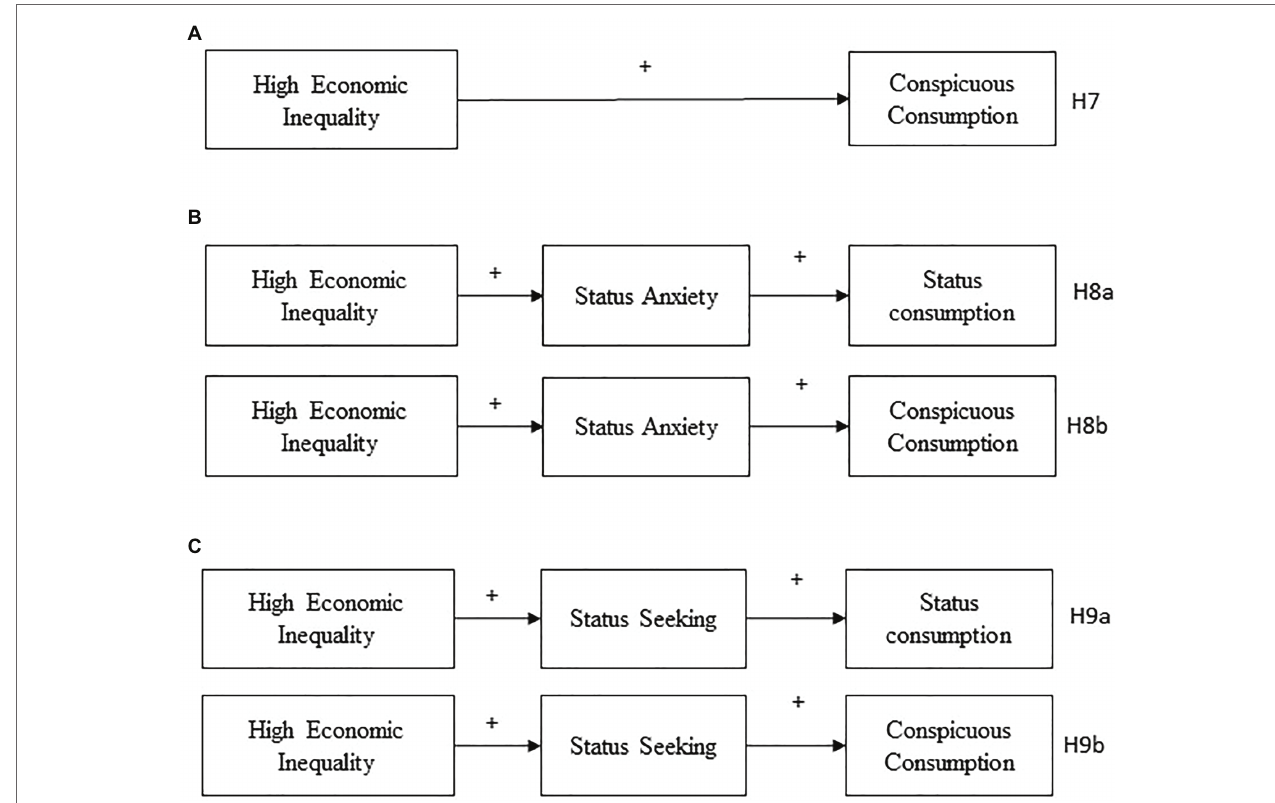
FIGURE 2 | Hypotheses of Study 2. Main effect of Economic Inequality on conspicuous consumption (A) . Indirect effect of economic inequality on status consumption and conspicuous consumption through status anxiety (B) . Indirect effect of economic inequality on status consumption and conspicuous consumption through status seeking (C) .